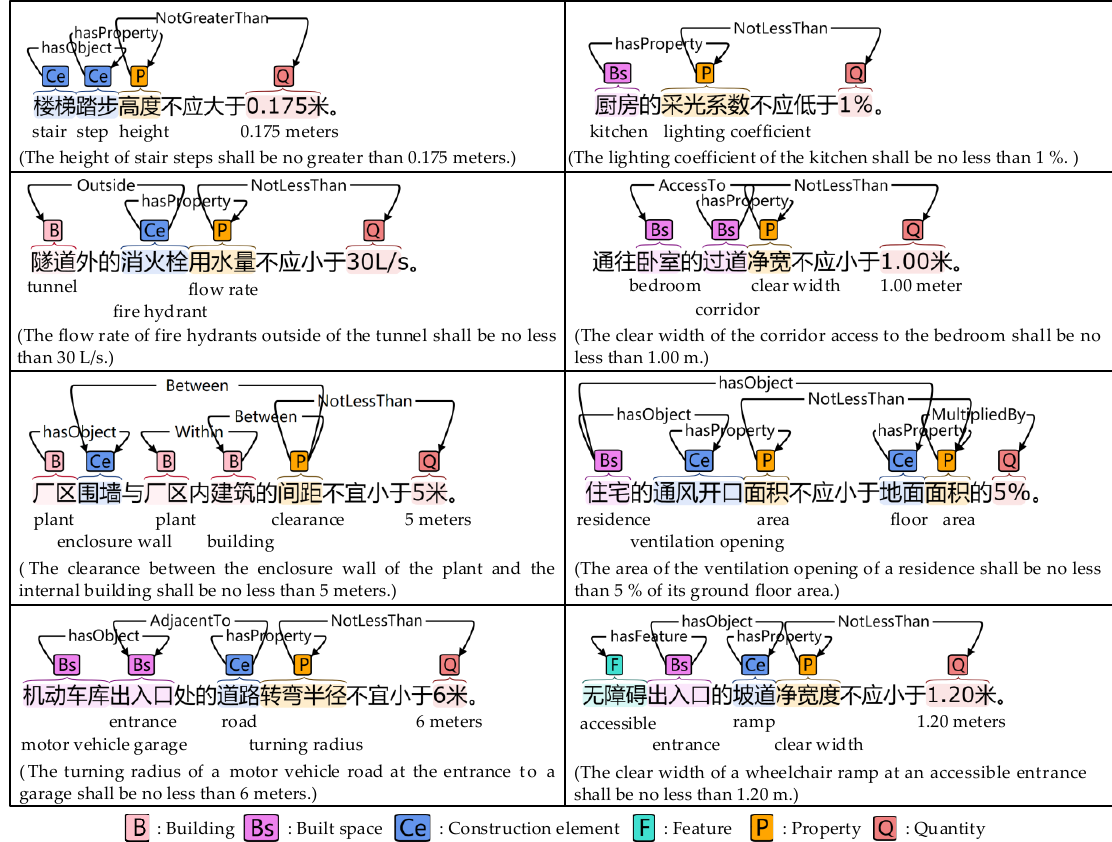
Figure 5. Labeled clauses for model training and testing